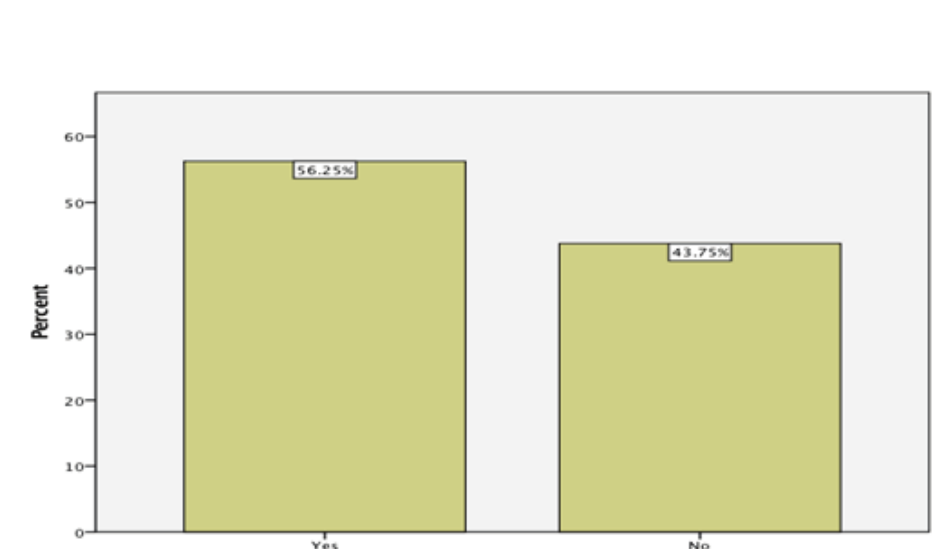
Figure 2: Staff practicing innovative methods of instruction before joining